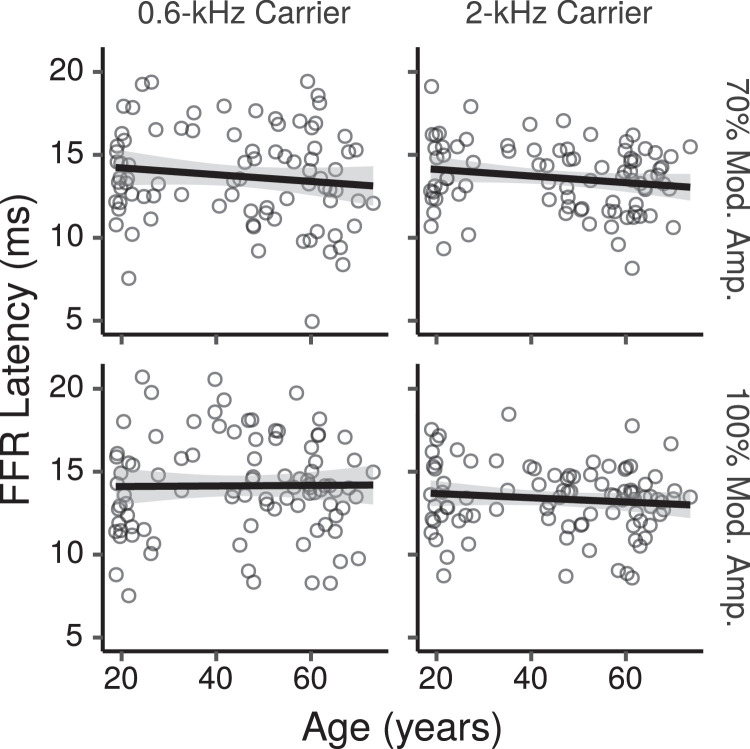
Across-montage average FFR ENV latency by age. Each panel shows a least squares line fit of FFR latency by age with 95% confidence intervals as a visual aid. The slope for the effect of age estimated by the Bayesian multiple regression model is not the same as that shown in the figure.